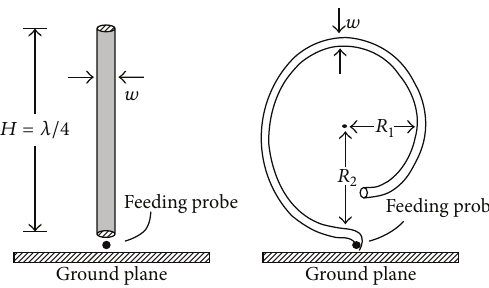
Figure 1: Quarter wavelength monopole, 𝜆/4 , twisted to form a single turn spiral microstrip antenna.